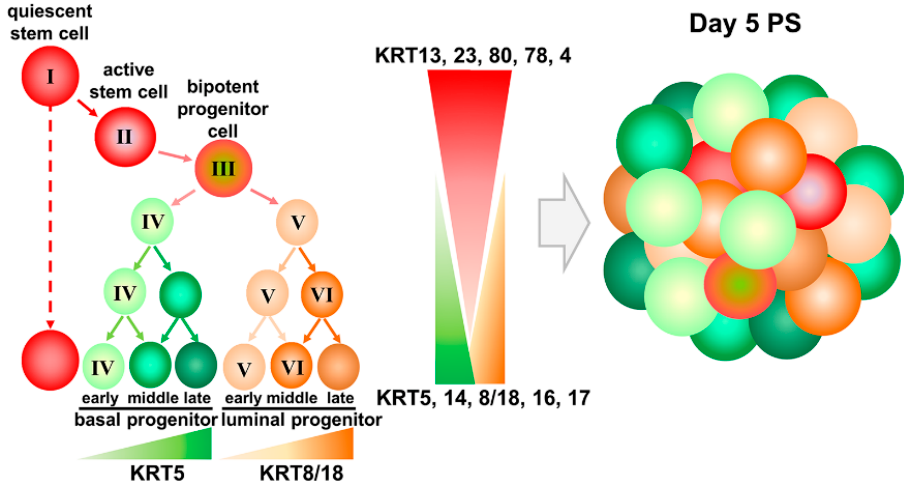
Figure 8. Model of prostate epithelial stem cell hierarchy based upon keratin profiles. Quiescent prostate stem cells ( cluster I : enriched for KRT13, 23, 80, 78, 4 ) become active stem cells ( cluster II ), with increased expression of KRT 16, 17, and 6 that generate bipotent progenitor cells ( cluster III ) and further give rise to committed unique potent basal progenitors ( cluster IV : enriched for KRT5, 14, 6, 16 ), as well as early ( cluster V ) and late-stage ( cluster VI ) luminal progenitors (enriched for KRT8, 18, 10 ).